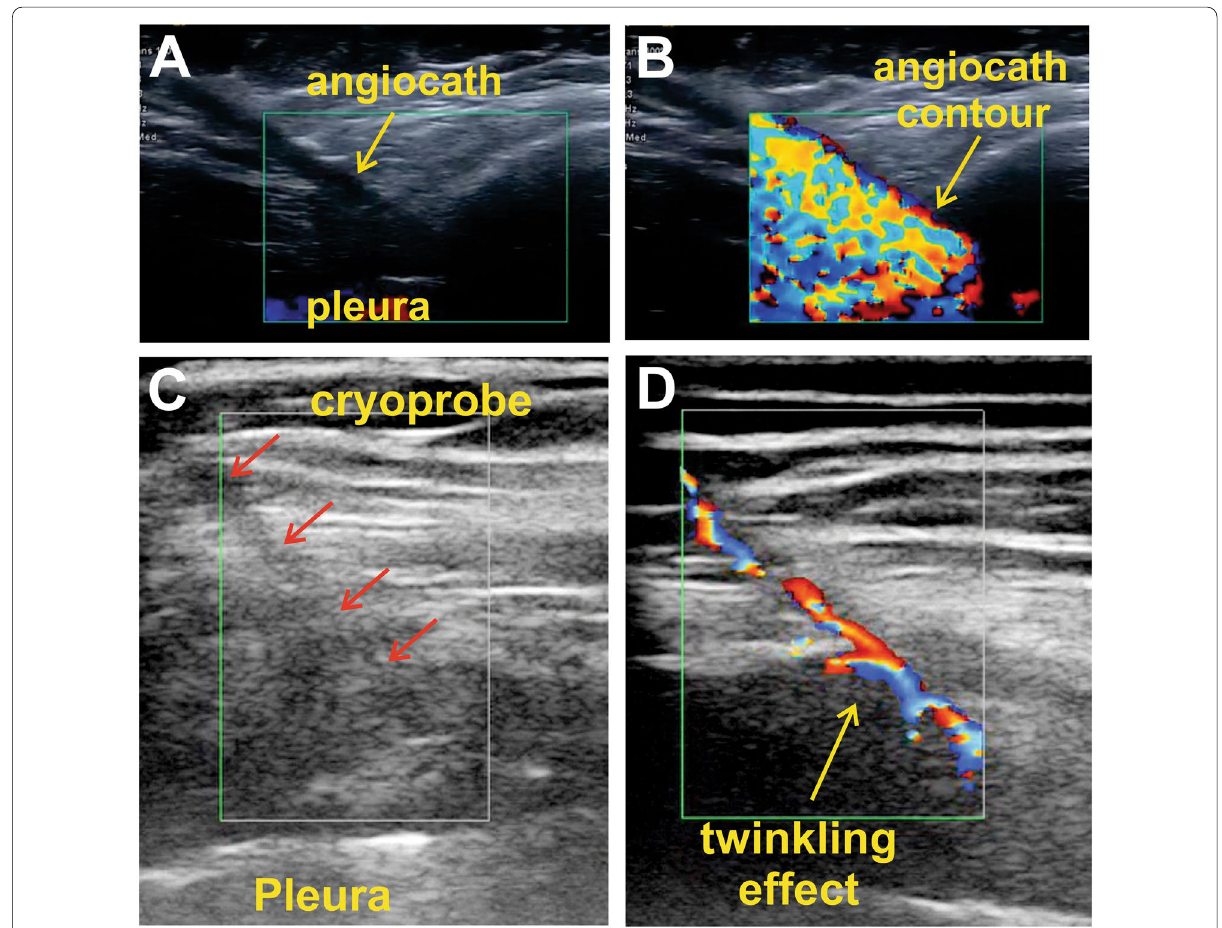
Fig. 2 Color Doppler twinkling artifact to visualize the angiocath and cryoprobe positioning. The images belong to a 77-year-old female (Figures A and B ) and a 63-year-old male (Figures C and D ) undergoing lobectomy by u-VATS. A Contour of the angiocath catheter (without internal stylet) is visible as a hypoechoic line highlighted by adjusting US contrast. B Injection of local anesthetic makes angiocath contour evident by the twinkling artifact. C Cryoprobe within the angiocath is not visualized despite tilting and US gray-scale image adjustments (faint shadow marked by red arrows). D Twinkling artifact localizing the tip above the